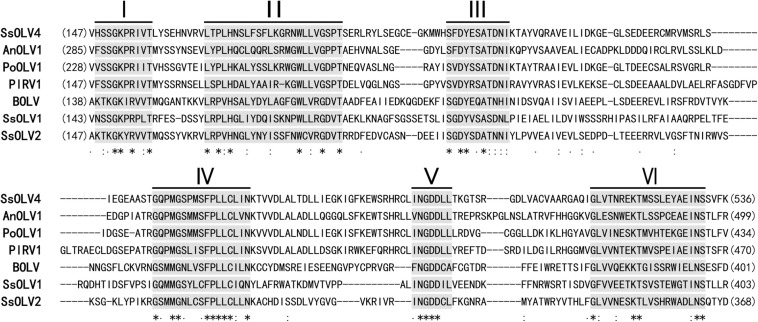
Multiple alignment of conserved amino acid motifs in RdRp regions of SsOLV4 and other selected ourmia-like viruses. The alignment was performed using ClustalX (2.0). The conserved motifs in RdRp of the compared viruses are shown by Roman numerals I to VI. “∗” indicates a same amino acid (aa) position; “:” indicates that one of the following ŚstrongŠ groups is fully conserved; “.” indicates that one of the following ‘weaker’ groups is fully conserved. Abbreviations of virus are listed in Table 2.